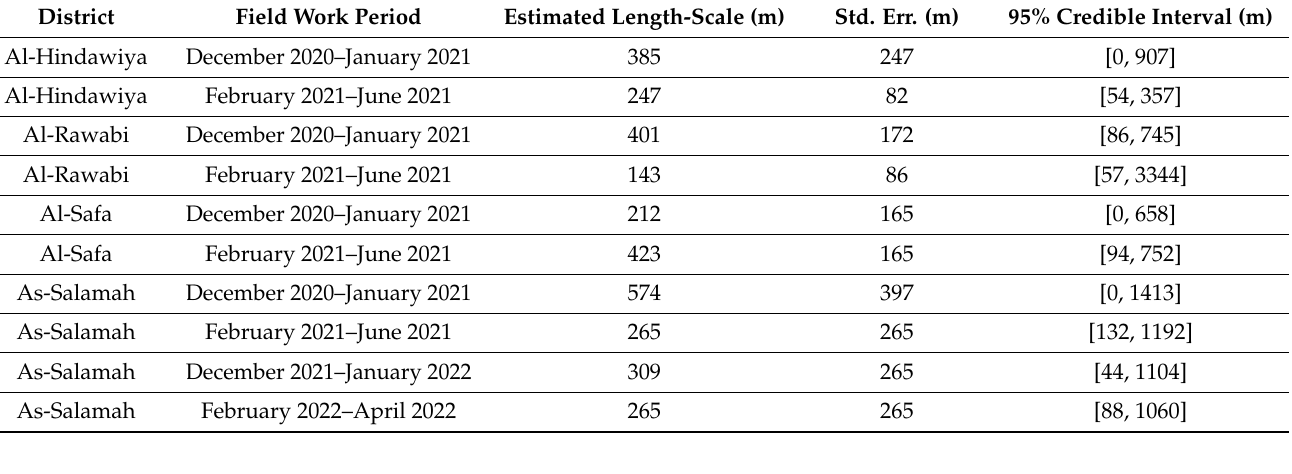
Table 2. Estimated length-scale parameters of covariance kernels in Gaussian process models for mean mosquito egg number per felt.